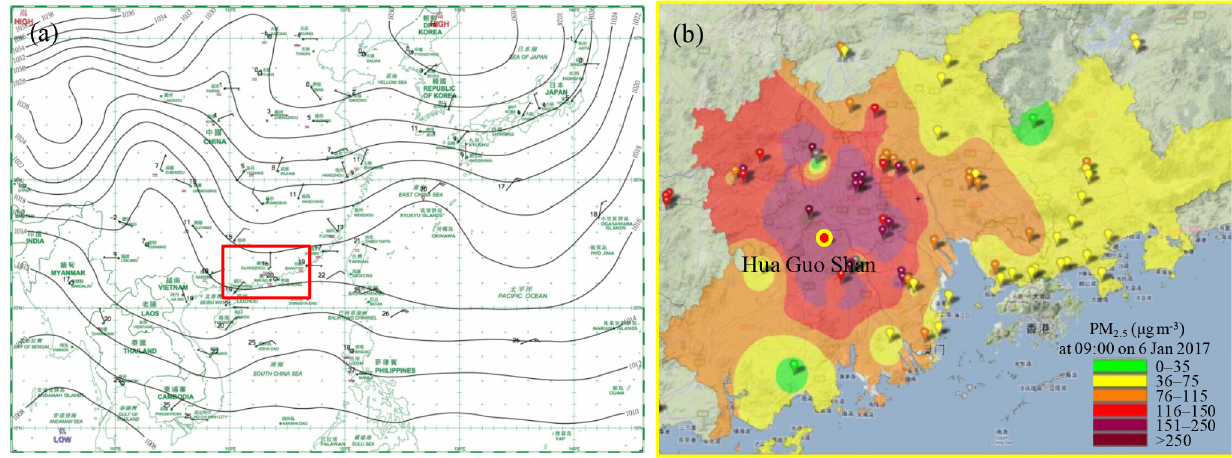
Figure 3. (a) Surface weather chart at 08:00LT on 6 January 2017, downloaded from the Hong Kong Observatory website, indicating stagnant conditions. (b) The distribution of PM 2 . 5 concentrations in the PRD region at 09:00LT on 6 January 2017. This figure was captured from the following website: http://113.108.142.147:20031/GDPublish/publish.aspx (last access: 17 November 2018).